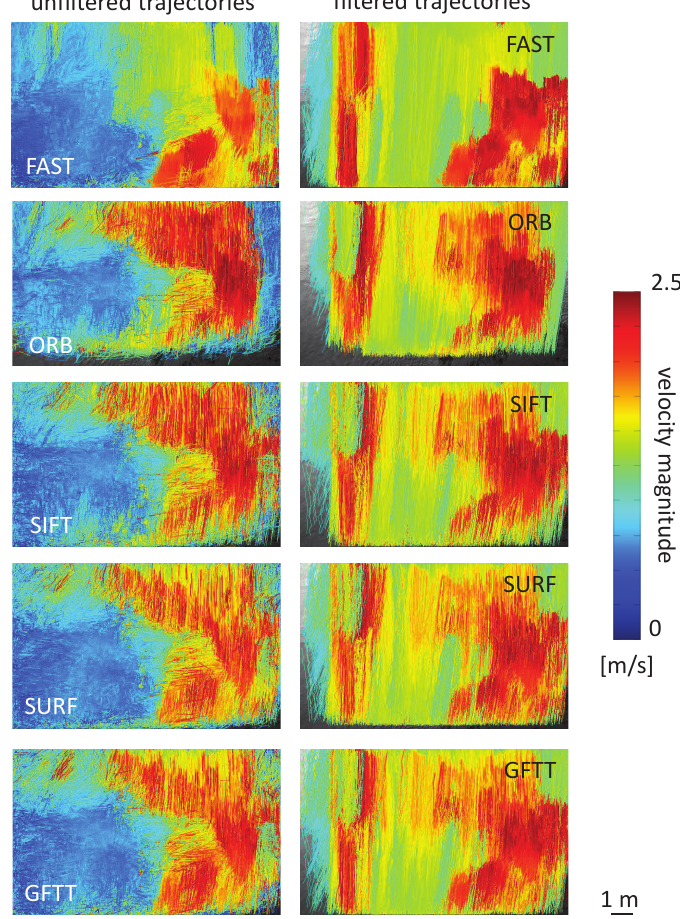
Figure 9. Unfiltered and filtered trajectories obtained with OTV and five different feature detectors for the video on the Tiber River. The colorbar indicates velocity magnitude for each trajectory computed as Equation (5). Flow direction is